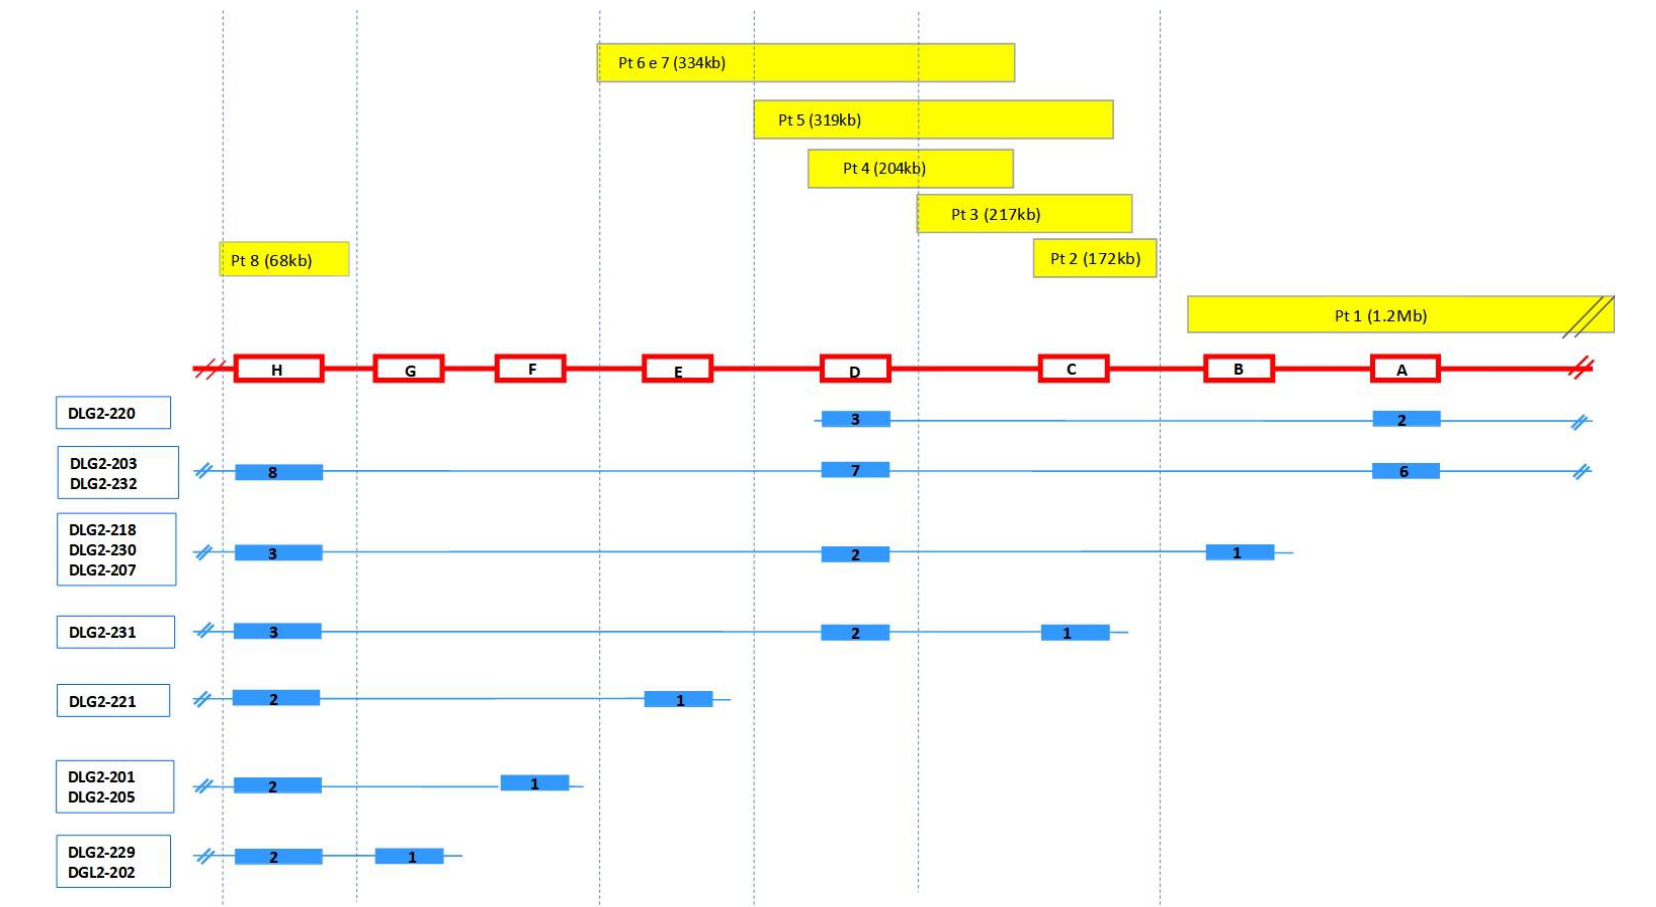
Figure 1. Genetic overview of DLG2 CNVs and the relative transcripts involved. Top: the yellow bars indicate the imbalances detected for each patient and their extent. Middle: coding regions are indicated by red boxes (right to left) and introns by red lines; A: ENSE00001469378; B: ENSE00002179742, ENSE00002149728, ENSE00002188311; C: ENSE00003840932; D: ENSE00003487678, ENSE00002174027; E: ENSE00002152856; F: ENSE00001532570; G: ENSE00003587836, ENSE00001469384; H: ENSE00003471737. For details, see Table S3. Bottom: DLG2 isoforms (blue) with the number of exons relative to each transcript are reported. Relative lengths are not to scale. Pt = patient.